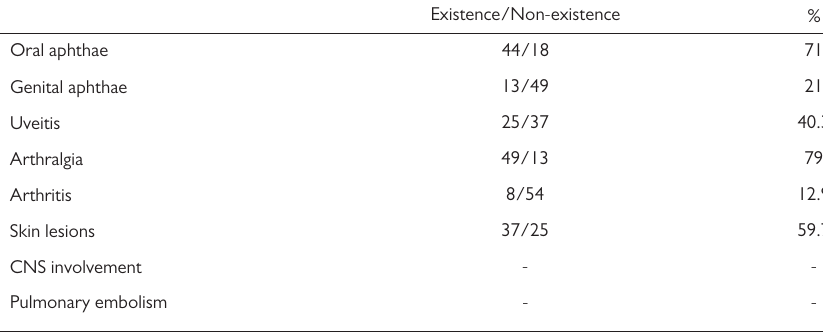
Table 2. The Clinical Manifestations of Patients with Behçet’s Disease